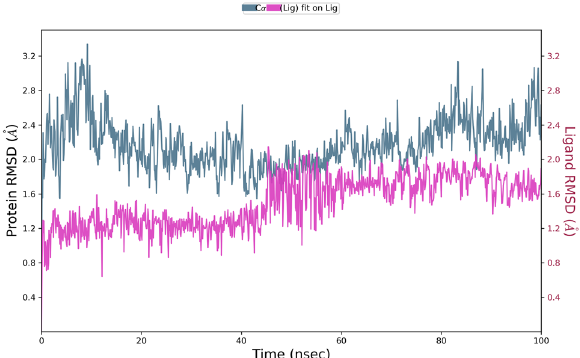
Figure 8. Root mean square deviation (RMSD) plot for interaction of curcumin and RBD/ACE2-complex during 0–100 ns of molecular dynamic